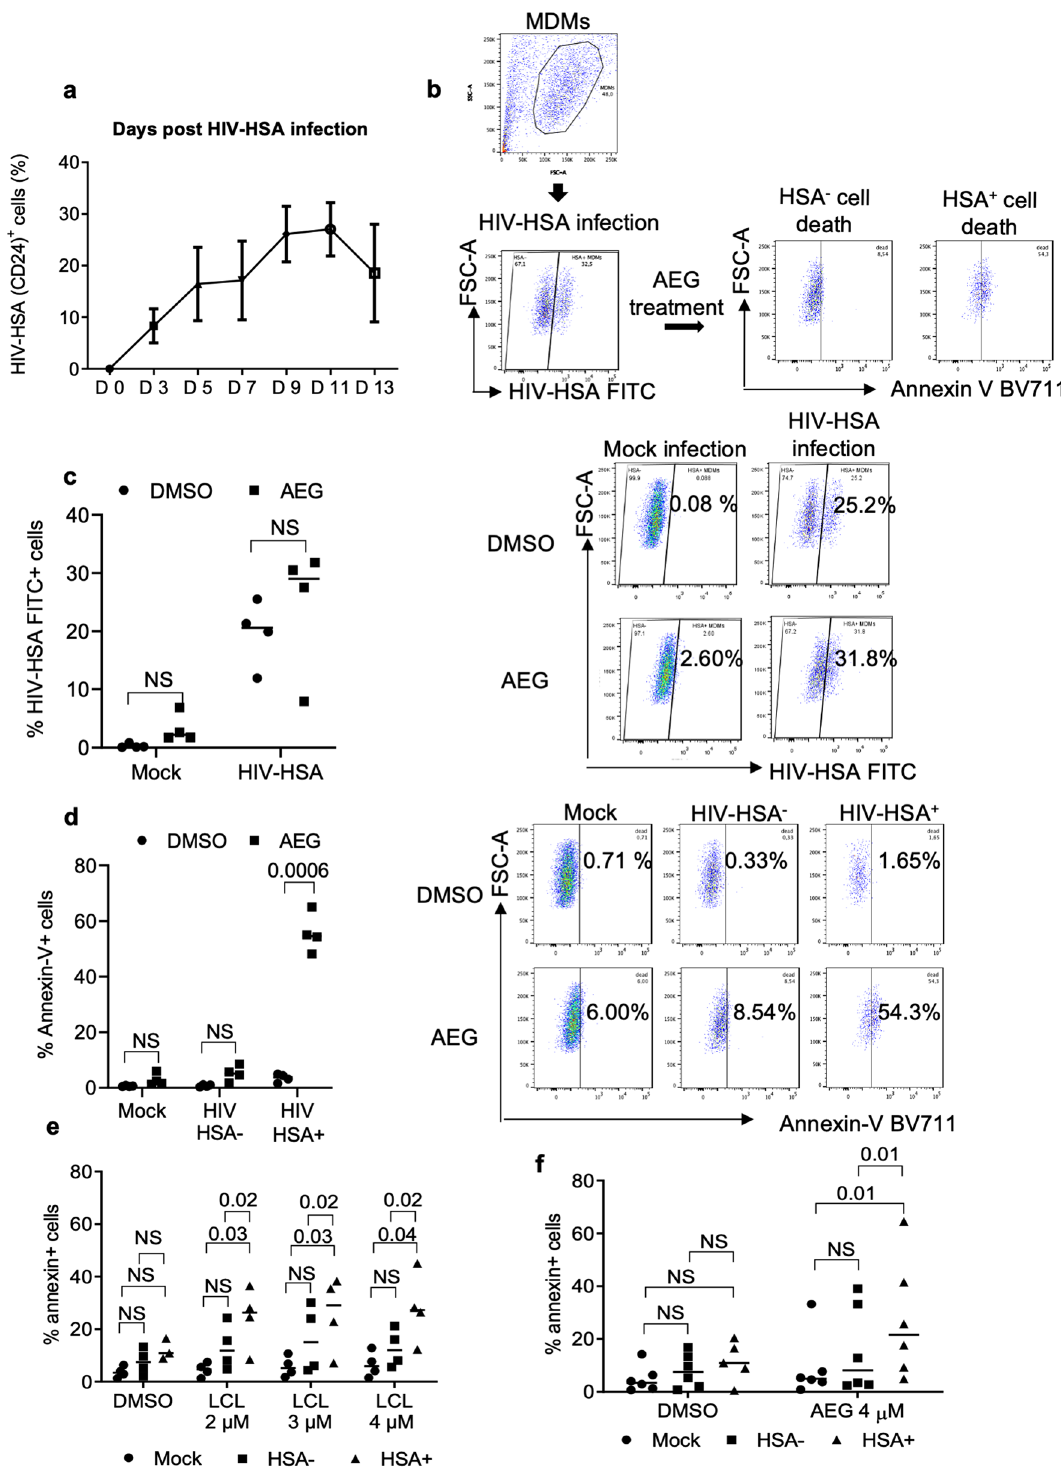
Figure 3. SM specifically induces cell death of HIV-HSA-infected MDMs. ( a ). MDMs from healthy donors were in vitro infected with HIV-HSA (100 ng p24/well). Infection rate over time was detected using anti-CD24 (HSA)-FITC antibody by flow cytometry. ( b ) Gating strategy for the detection of apoptosis by Annexin-V staining of HIV-infected total (HSA + and HSA −) MDMs. ( c ) The in vitro HIV-HSA-infected MDMs 7 days post-infection were treated with 5 µM of AEG40730 (AEG) for 72 h and degree of infection was determined by anti-CD24 (HSA) antibody staining and flow cytometry (left panel) (n = 4). Representative scatter plots of HIV-HSA FITC + cells are shown (right panel). ( d ) Degree of cell death after AEG treatment of mock, HSA + and HSA-HIV-infected cells was assessed by annexin-V-BV711 staining and flow cytometry (left panel) (n = 4). Representative scatter plots show annexin-V-BV711 cells (right panel). LCL161 ( e ) and AEG 40730 ( f ) specifically kill HIV-HSA-infected cells but not HIV-HSA negative MDM. MDMs were infected with HIV-HSA for 11 days followed by treatment with either LCL161 or AEG40730 for another 48 h followed by analysis of cell death by PI staining (n = 5). The p values were calculated using two tailed Mann–Whitney U